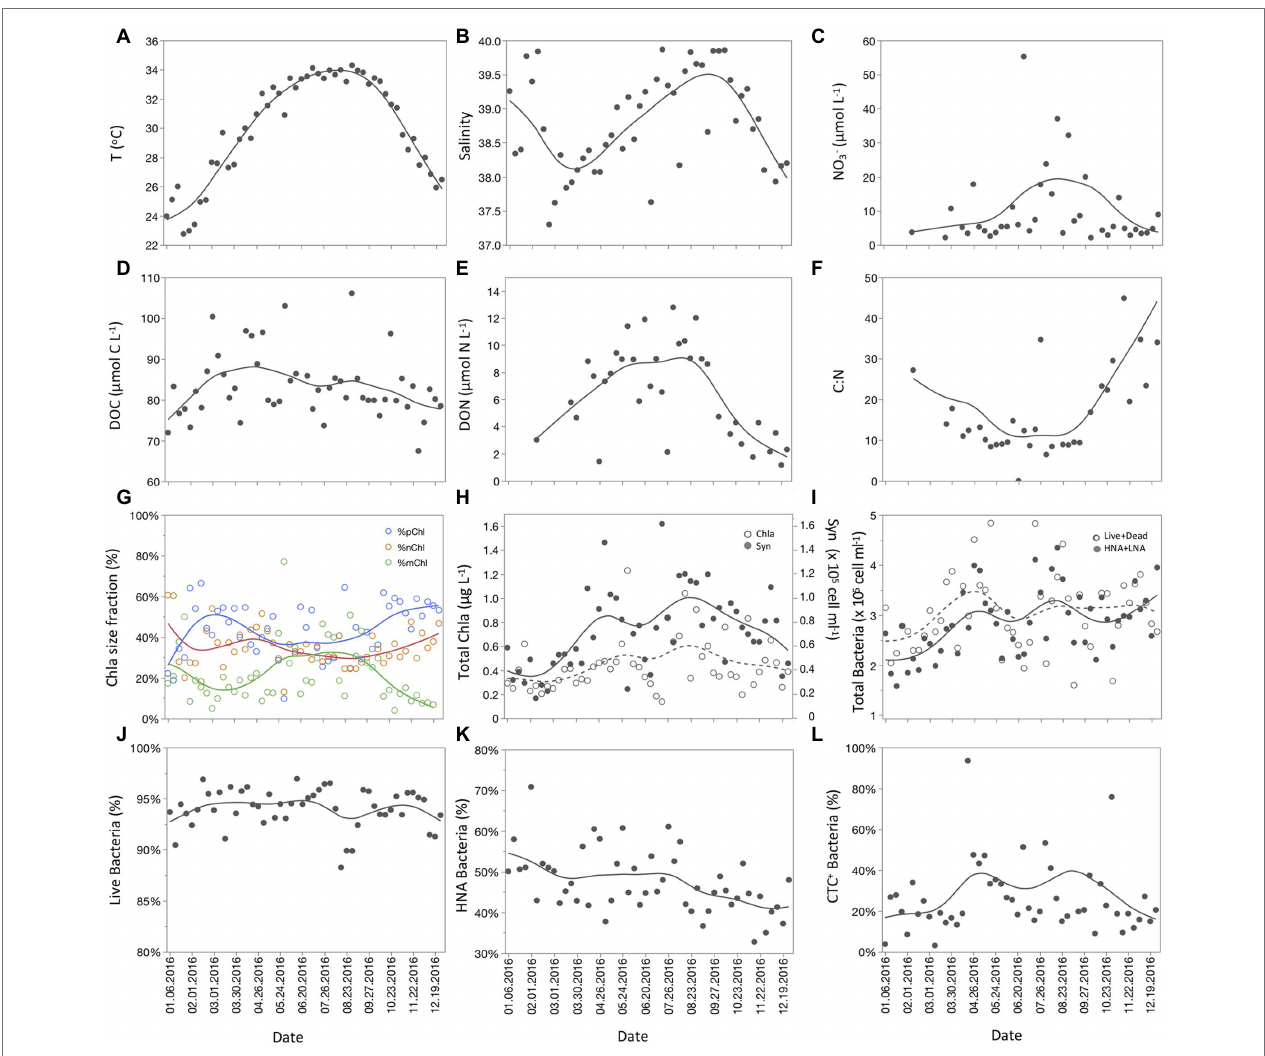
FIGURE 1 | Temporal distribution of different environmental variables and bacterioplankton groups at the Red Sea coastal site: (A) temperature ( ° C); (B) salinity; (C) nitrate concentration ( μ mol L − 1 ); (D) DOC concentration ( μ mol L − 1 ); (E) DON concentration ( μ mol L − 1 ); (F) DOM C:N ratios; (G) the percentage of the different size fractions pico-Chl a (blue), nano-Chl a (orange), and micro-Chl a (green); (H) total Chl a concentration ( μ g L − 1 ; empty circles, dashed line) and Synechococcus abundance (cells mL − 1 ; full circles, solid line); (I) total heterotrophic bacterial abundance (cells mL − 1 ) considering the sum of live and dead bacteria (empty circles, dashed line) and the sum of HNA and LNA bacteria (full circles, solid line); (J) percentage of HNA bacteria (%); (K) percentage of Live bacteria (%); (L) percentage of actively respiring bacteria or CTC + (%). The smooth curves fitted in each plot are weighted functions using the cubic spline with a lambda of 0.05 and standardized X values, generated on JMP Pro 16